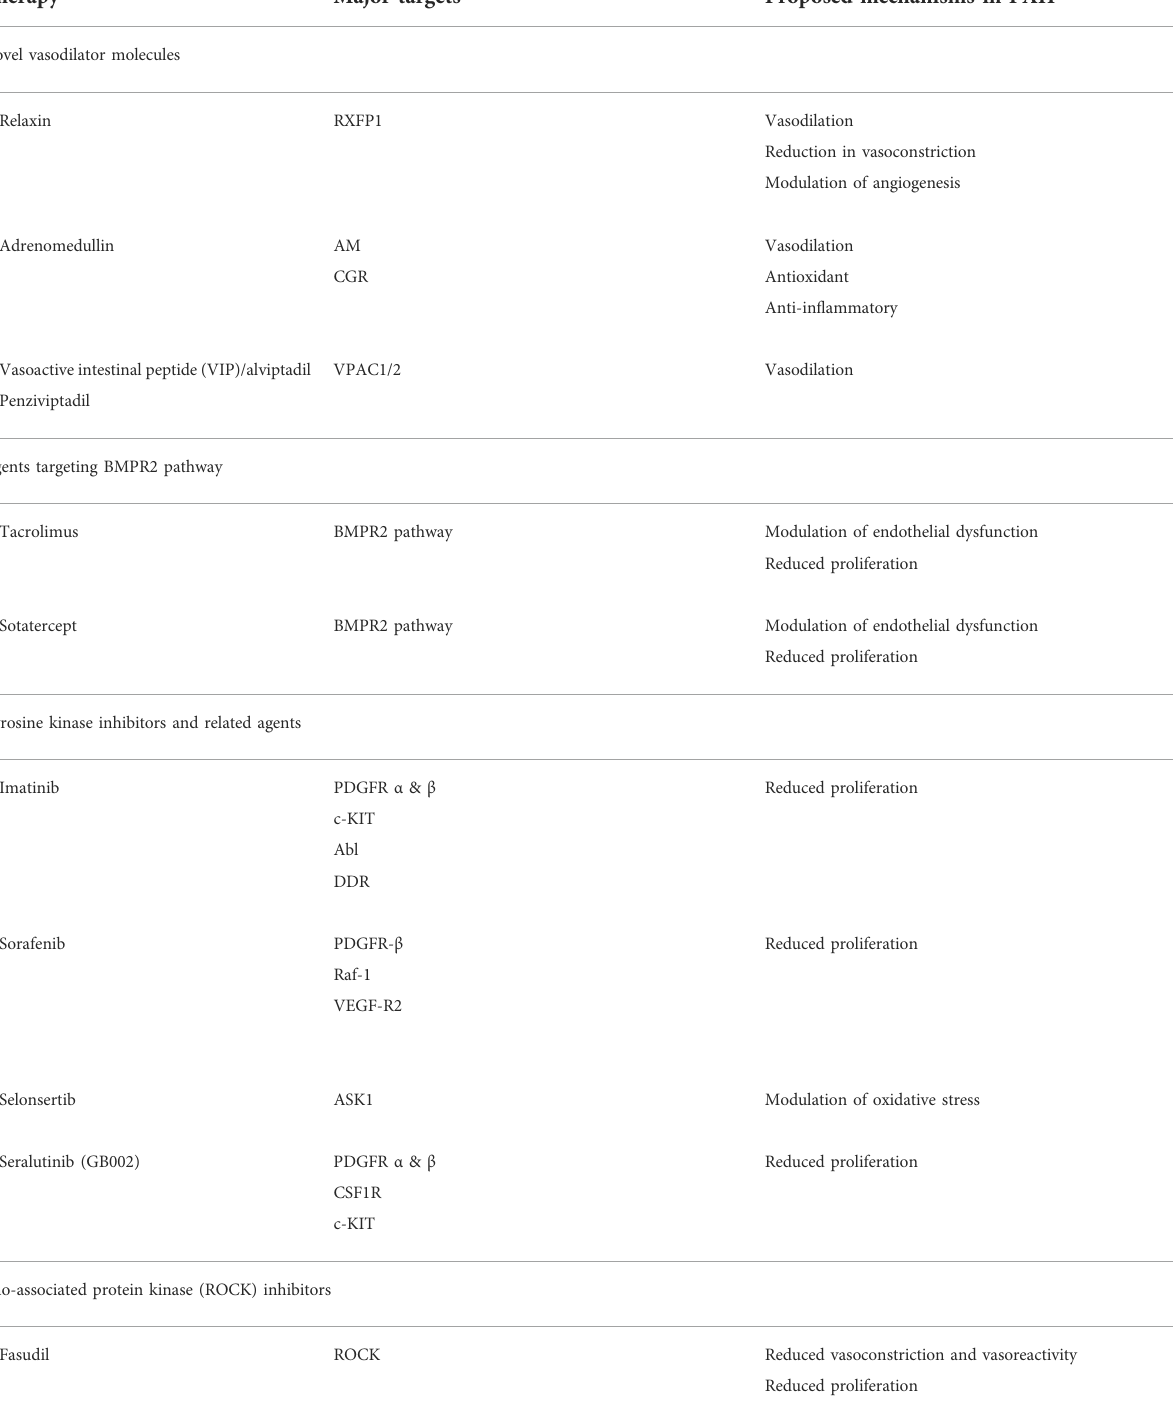
TABLE 3 Selected novel treatment agents for pulmonary arterial